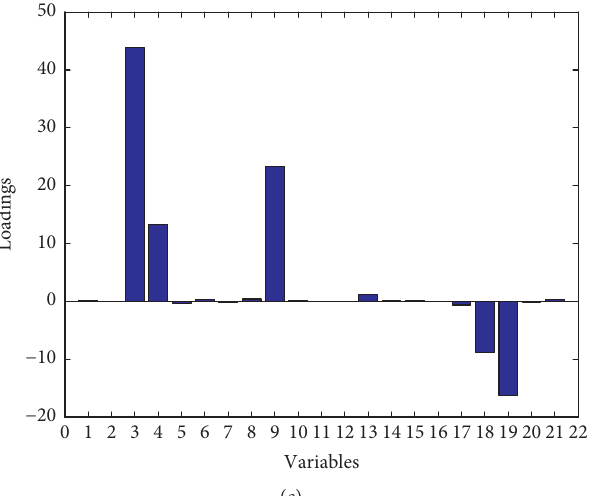
Figure 1: Scores (a) and loadings (b and c) of the first two principal components (PCs) obtained by principal component analysis (PCA) of 21 quality factors for 12 cultivars of blueberries.